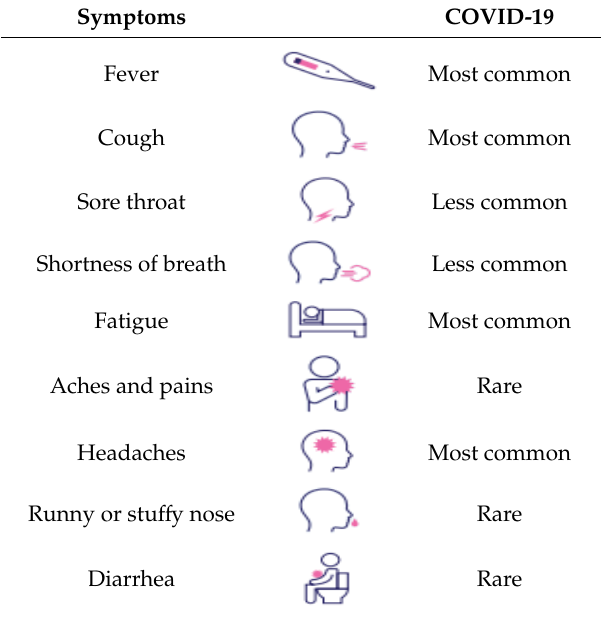
Table 2. Summary of COVID-19 symptoms. Table 2: Summary of covid-19 symptoms. Table 2: Summary of covid-19 symptoms. Table 2: Summary of covid-19 symptoms. Table 2: Summary of covid-19 symptoms. Table 2: Summary of covid-19 Table 2: Summary of covid-19 symptoms. Table 2: Summary of covid-19 symptoms. Table 2: Summary of covid-19 symptoms. Table 2: Summary of covid-19 symptoms.